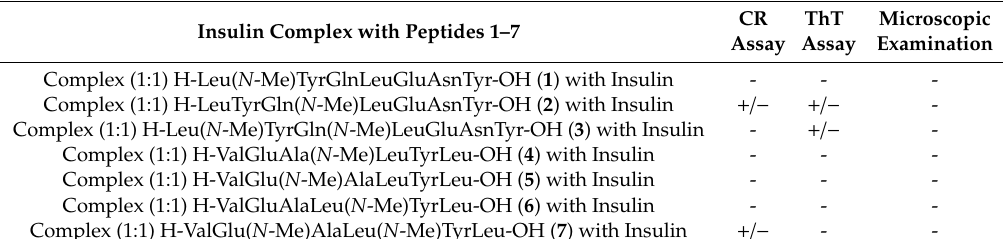
Table 1. Summary of results: inhibition of insulin aggregation by peptides 1 – 7 .